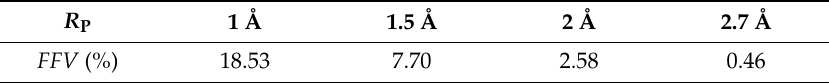
Table 6. FFV of PE cell with the di ff erent probe